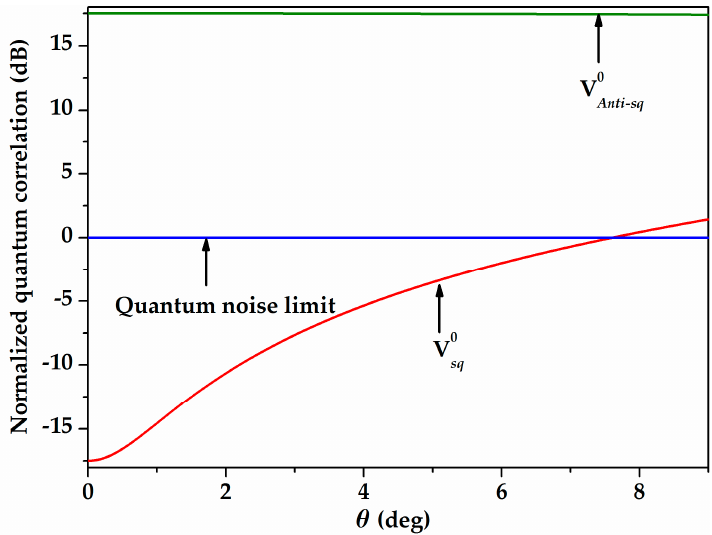
Figure 2. The simulated quantum correlation as a function of the relative phase fluctuation.